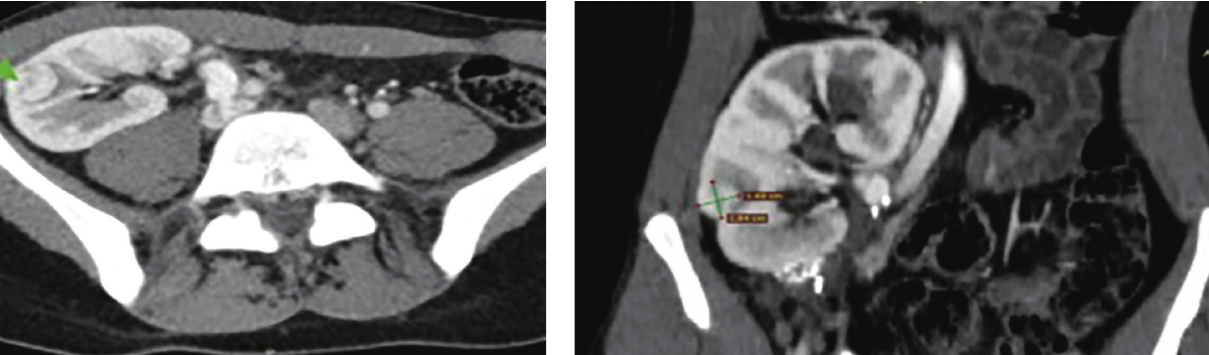
Figure 1 -CT image before radiofrequency ablation